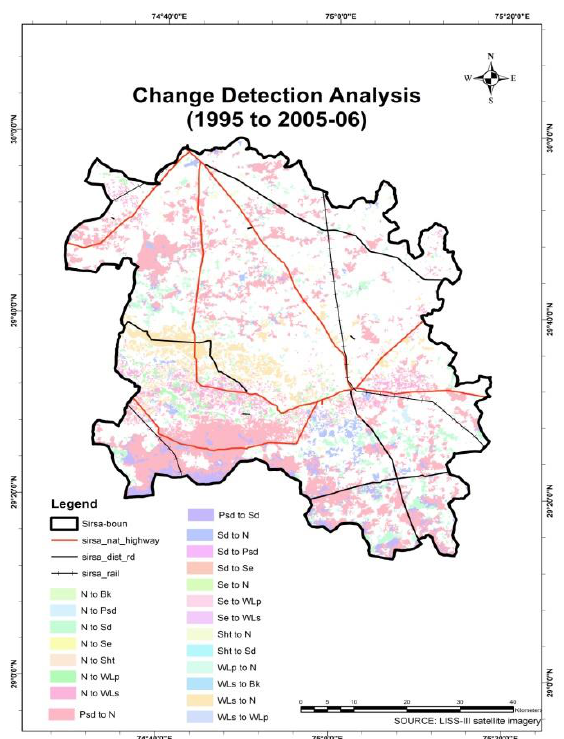
Figure 2. Map showing change in categories of degraded lands